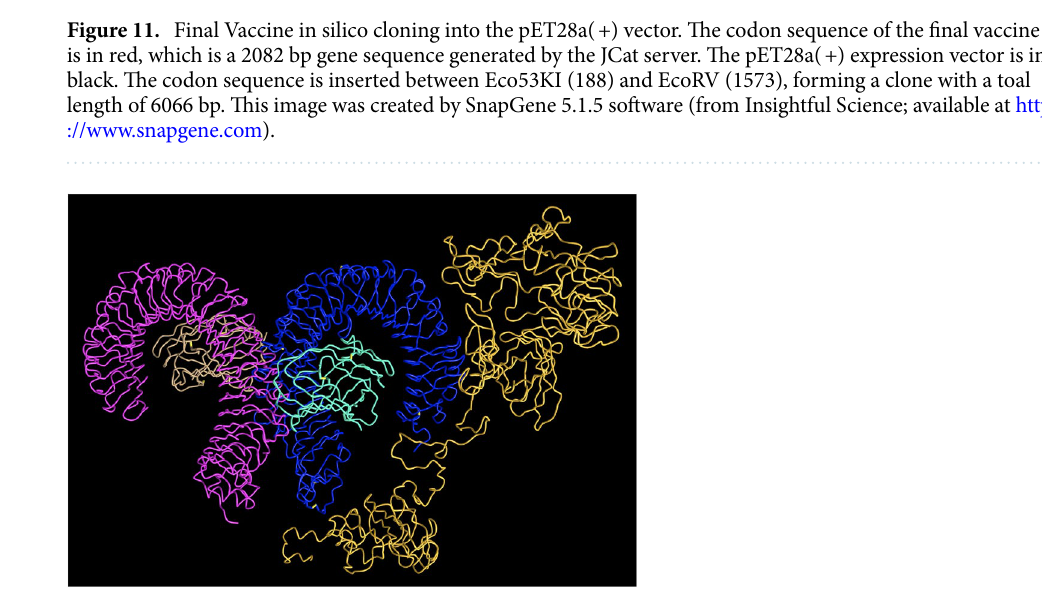
Figure 12. The docked complex of the vaccine model and the TLR4 immune receptor. The vaccine protein is in yellow and the rest of the residues is the TLR4 receptor. The lowest energy score of this complex model is -1311.5, indiating good binding